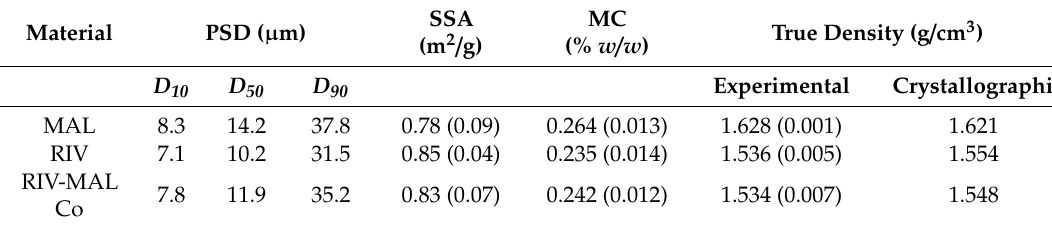
Table 1. Physical Characterization of MAL, RIV, and RIV-MAL